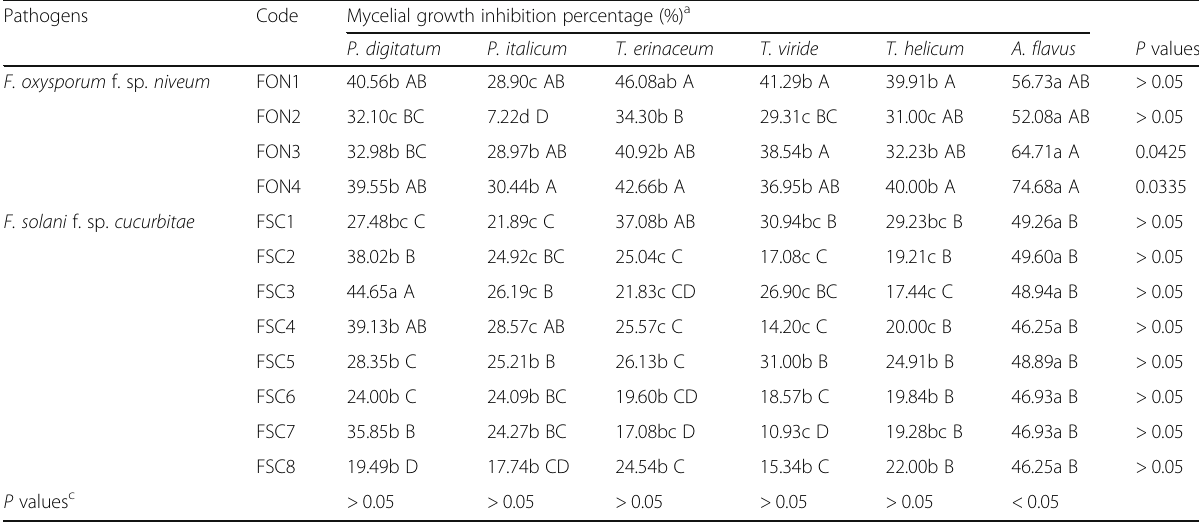
Table 3 Effect of direct dual confrontation, of two Penicillium spp. isolates, three Trichoderma spp. isolates, and Aspergillus flavus , on mycelia growth inhibition of four F. oxysporum f. sp. niveum isolates and eight F. solani f. sp. cucurbitae isolates after 5 days of incubation at 28 °C, means of six Petri plates (two plates per